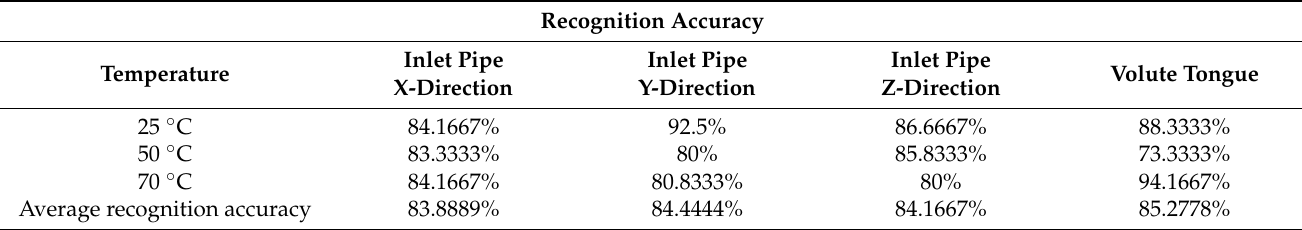
Table 4. Accuracy of multi-classification recognition of time domain combined eigenvalues.